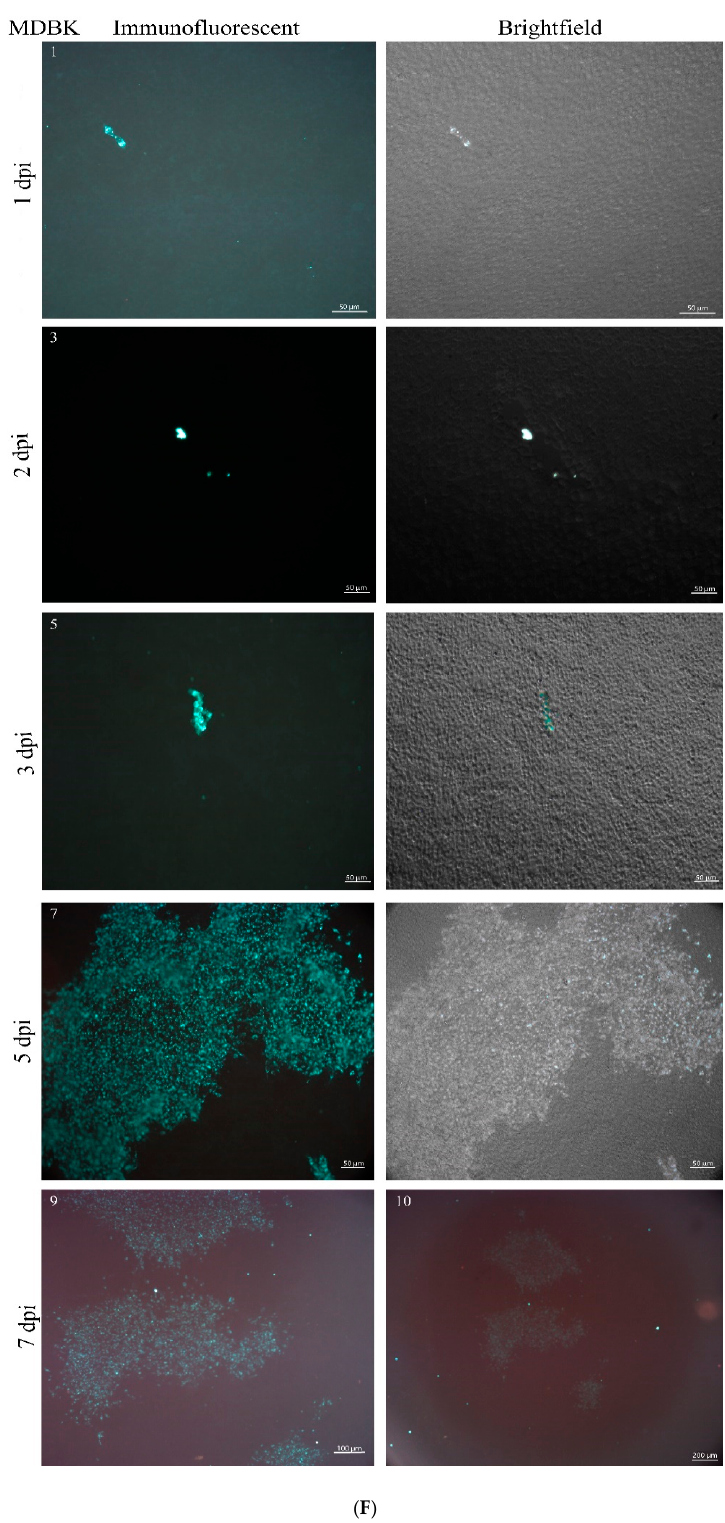
Figure 3. IIFA in primary and immortalized human and bovine kidney cells infected by CCHFV at days one, two, three, five, and seven dpi. Measurements were made in triplicates. Uninoculated cells were used as control. Merged brightfield and fluorescent images are indicated at the right side of the picture. Human kidney cells were infected with a broad distance from each other starting from three dpi, while infected bovine kidney cells remained restricted during the whole infection cycle and